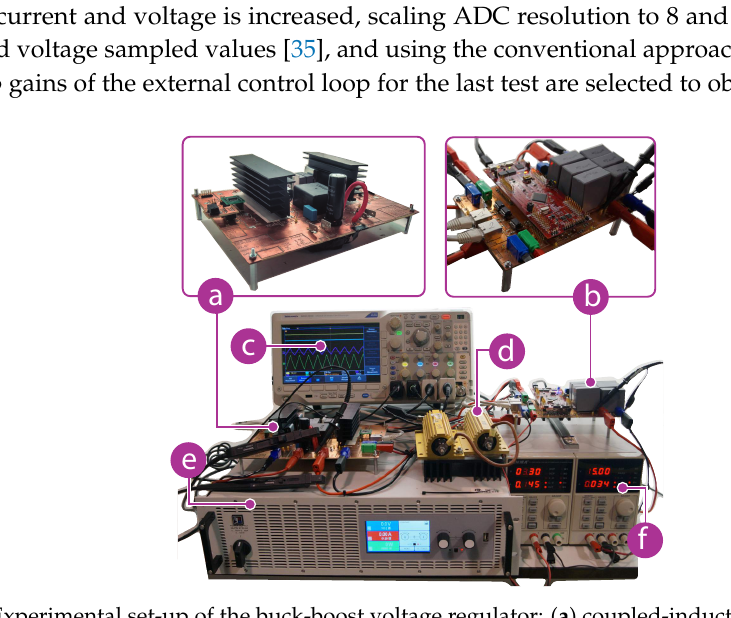
Figure 4. Experimental set-up of the buck-boost voltage regulator: ( a ) coupled-inductor buck-boost power stage, ( b ) digital signal controller with output capacitor C o = 28 µ F, ( c ) oscilloscope, ( d ) constant resistive